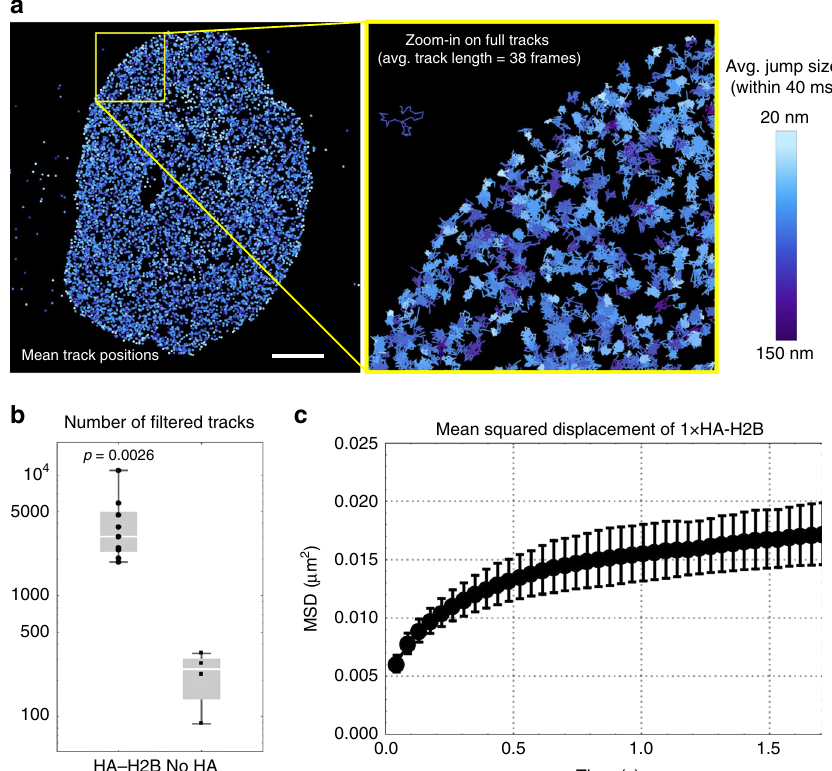
Fig. 5 Single molecule tracking of 1 × HA-tagged proteins in cells. a The mean positions of tracks of single frankenbody (FB) bound to 1 × HA-H2B provides a mobility map of H2B across the cell nucleus (10,949 tracks were generated from 977,516 total FB localizations). Tracks are color coded according to their average frame-to-frame jump size. The lighter colored tracks with relatively small jump sizes are enriched along the edge of the cell nucleus, where heterochromatin is typically enriched. To ensure tracks represent FB bound to HA-H2B, tracks were fi ltered such that their length had to be at least 16 consecutive frames and jumps between frames had to all be <220 nm. Full tracks within the yellow box are displayed in the zoom-in on the right. See also Supplementary Movie 2. b In cells expressing HA-H2B, the number of fi ltered FB tracks were between one and two orders of magnitude greater than in control cells lacking HA-H2B, demonstrating false-positive tracks are rare (see Supplementary Fig. 5). c The average mean-squared displacement of tracks provides a good estimate for average HA-H2B mobility. All tracks are from n = 9 cells in three independent experiments. Student ’ s t -test. Error bar, cell-to- cell SD of the average MSD. Scale bar, 5 µ m. Source data are provided as a Source Data fi le. For the box and whisker plots, median is shown by a white line, the box indicates 25 – 75% range, and whiskers indicate 5 – 95%